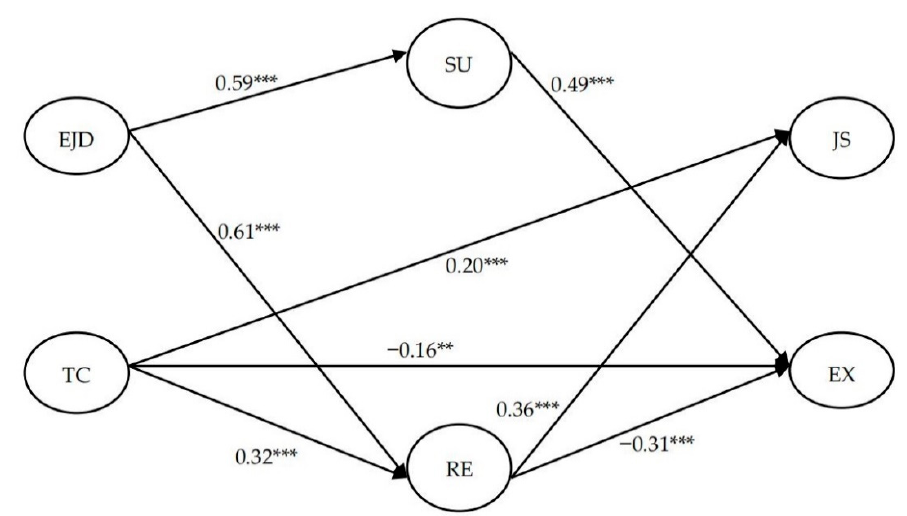
Figure 2. Path analysis results of the hypothesized model (showing significant paths only). Note: ** p < 0.01, *** p < 0.001. EJD = emotional job demands, TC = trust in colleagues, RE = reappraisal, SU = suppression, EX = emotional exhaustion, JS = job satisfaction.